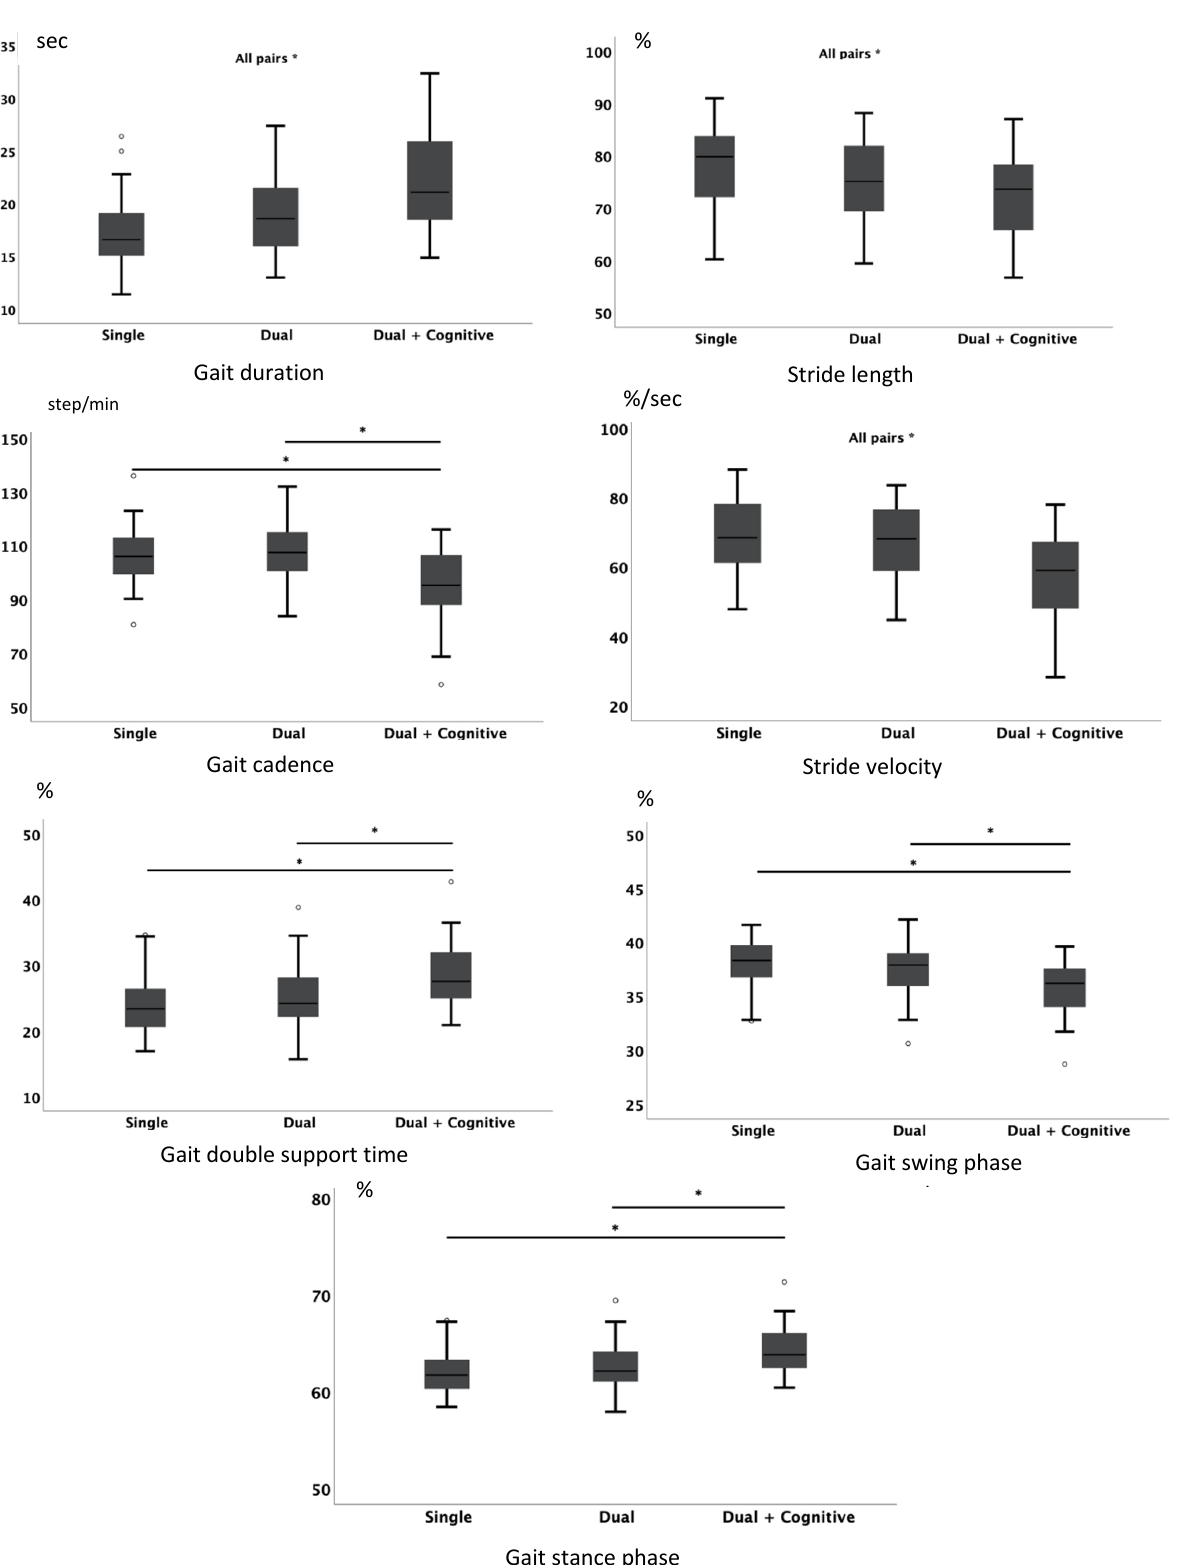
Figure 4. Gait parameters for the three conditions: single task, dual task, and dual and cognitive task during the ITUG test. * Significant differences for pairwise